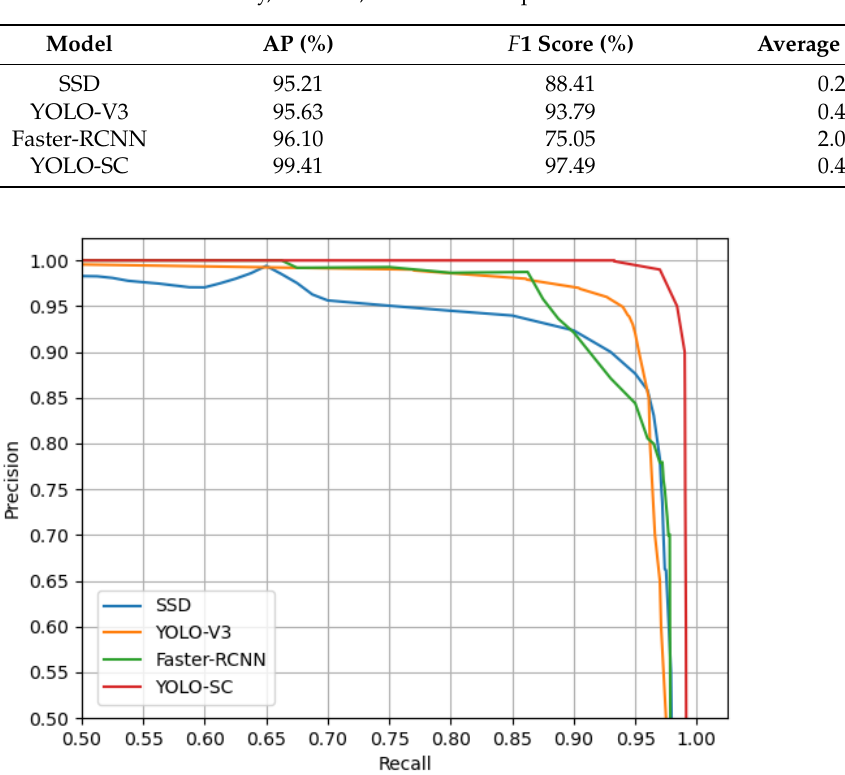
Table 6. Detection accuracy, F 1 score, and detection speed of different models.